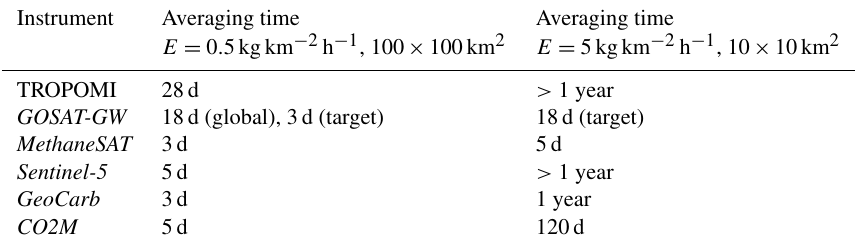
Table 3. Averaging time requirements for regional source detection by area flux mappers a . Instrument Averaging time Averaging